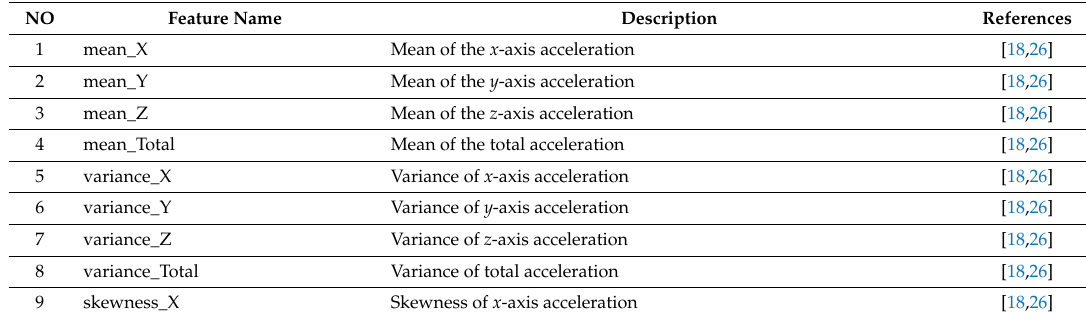
Table 2. The 45 available features considered by the fall classification